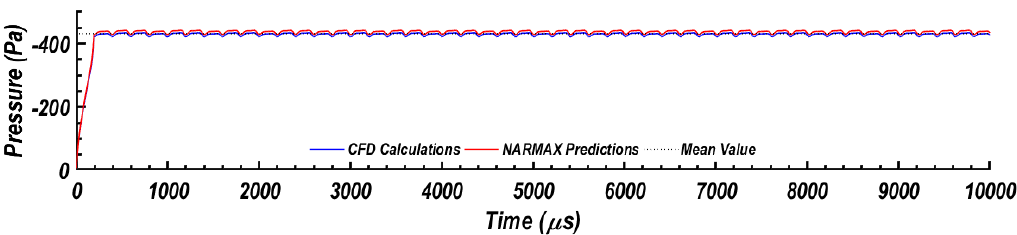
Figure 9. Comparison of moving average of the pressure response as obtained from CFD calculations and NARMAX predictions for constant input.